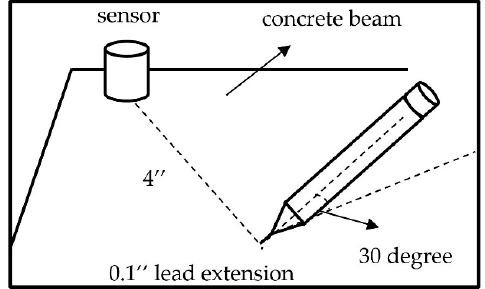
Figure 6. The pencil lead fracture test for sensor selection.